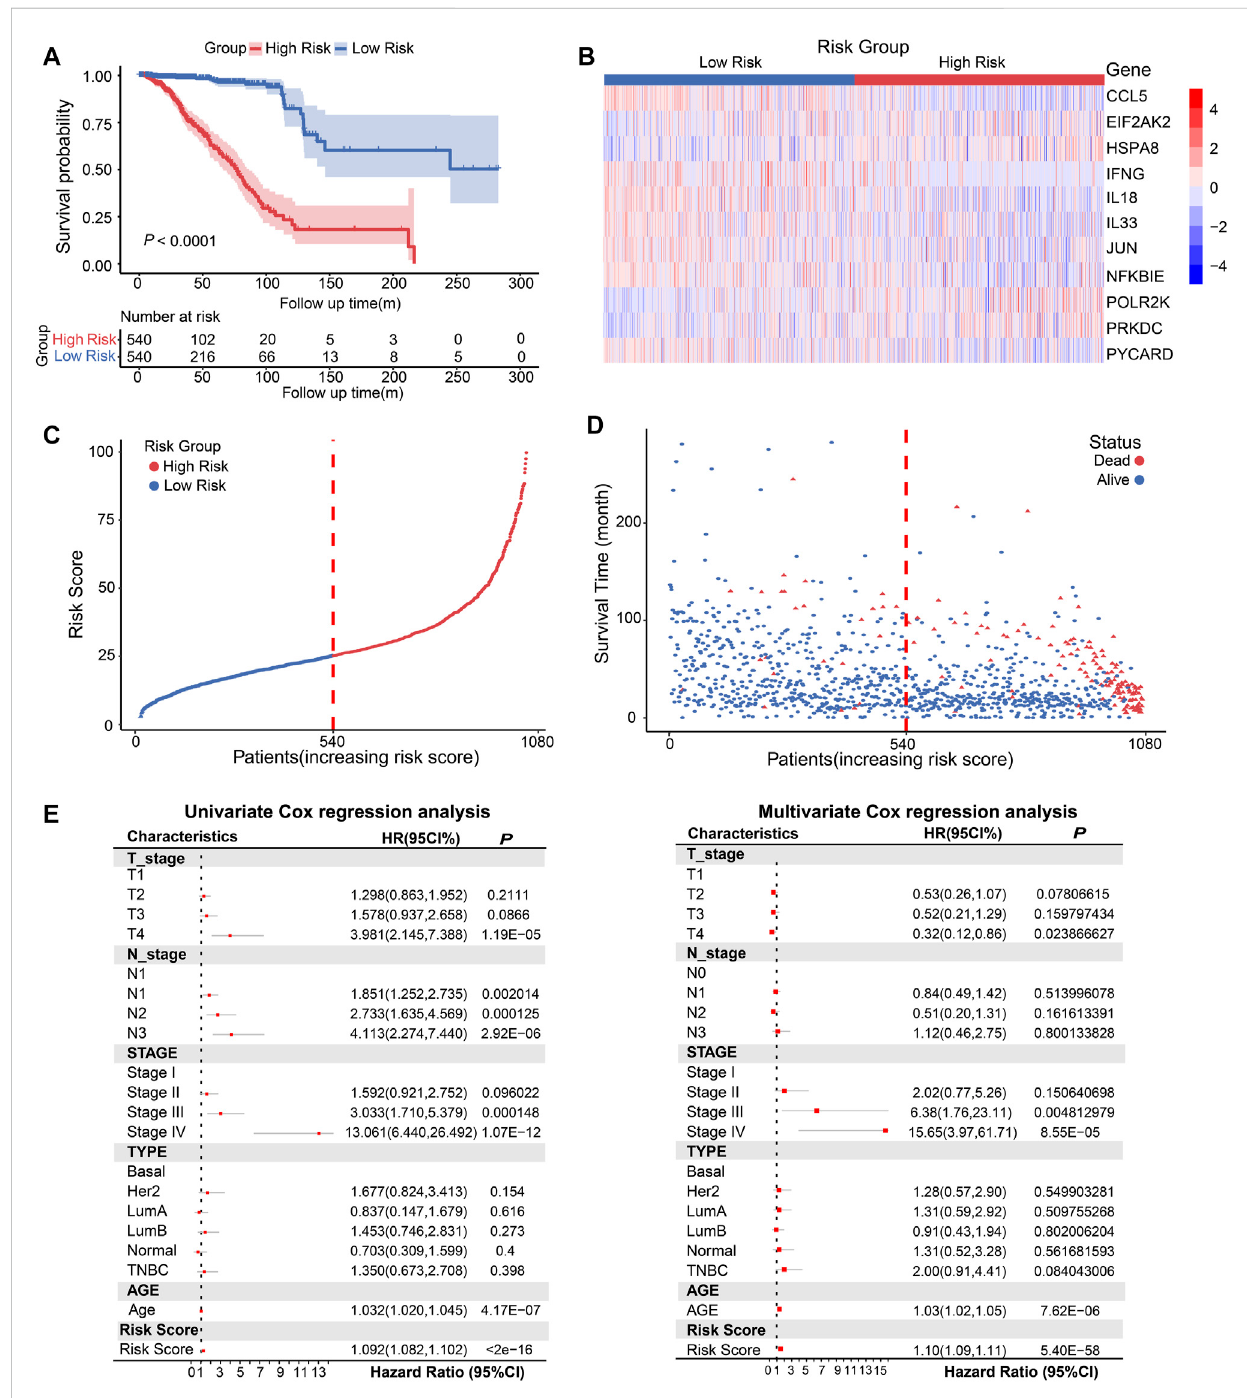
FIGURE 3 ConductionandevaluationoftheCSRGsriskscoremodelinBRCApatients. (A) Kaplan-MeiercurveshowedtheOSofBRCApatientsinhigh-riskand low-risk score groups. (B) Heat map presented the expression pattern of 11 prognostic-associated CSRGs in two risk score groups. (C) The ranked dot plot represented the risk score distribution characteristic in breast cancer patients. (D) Scatter plot performed survival status of patients with increasing risk score. (E) Forest plot of univariate and multivariate Cox regression analyses of the association between OS and clinicopathological factors (including the risk score) in BRCA patients; HR, hazard ratio; 95% CI, 95% con fi dence